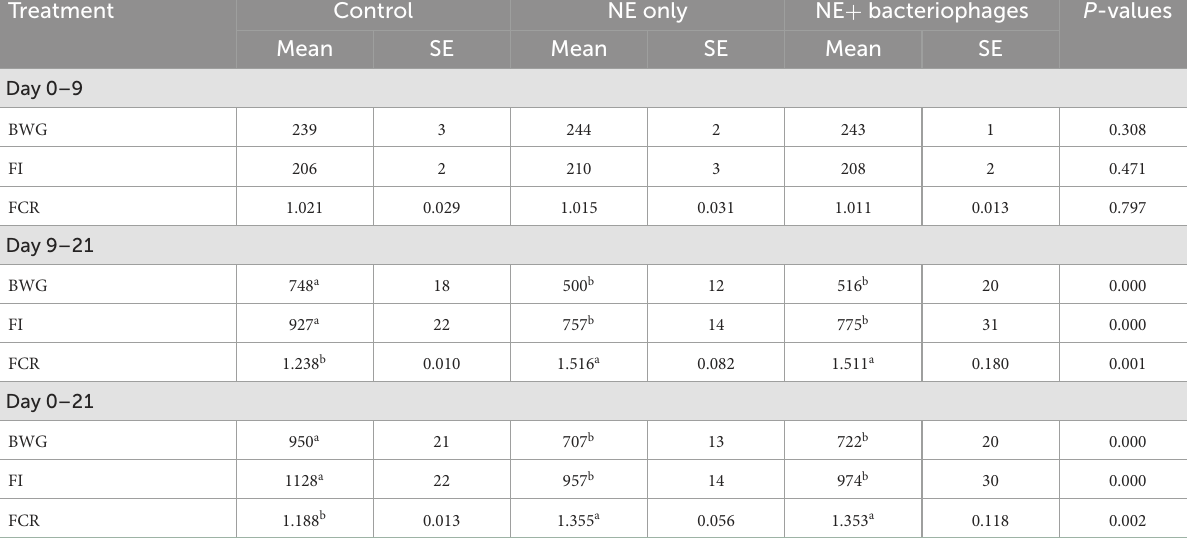
TABLE 4 Lesion scores of the birds under treatments at day 16 ∗ . Treatment